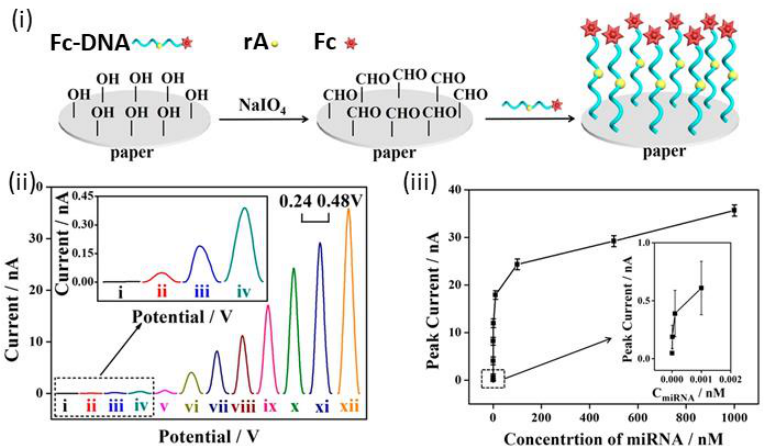
Figure 13. Preparation of paper-based electrochemical sensing platform for miRNA based on the immobilization of ferrocene (Fc)-labeled DNA (Fc-DNA) on paper (i). Detection of the lung cancer-specific biomarker miRNA-21 at different concentrations by differential pulse voltammetry (DPV) (ii) and the corresponding calibration curve (iii) [193]. Copyrights: all images have been adapted and reproduced with permission from © 2019, American Chemical Society.